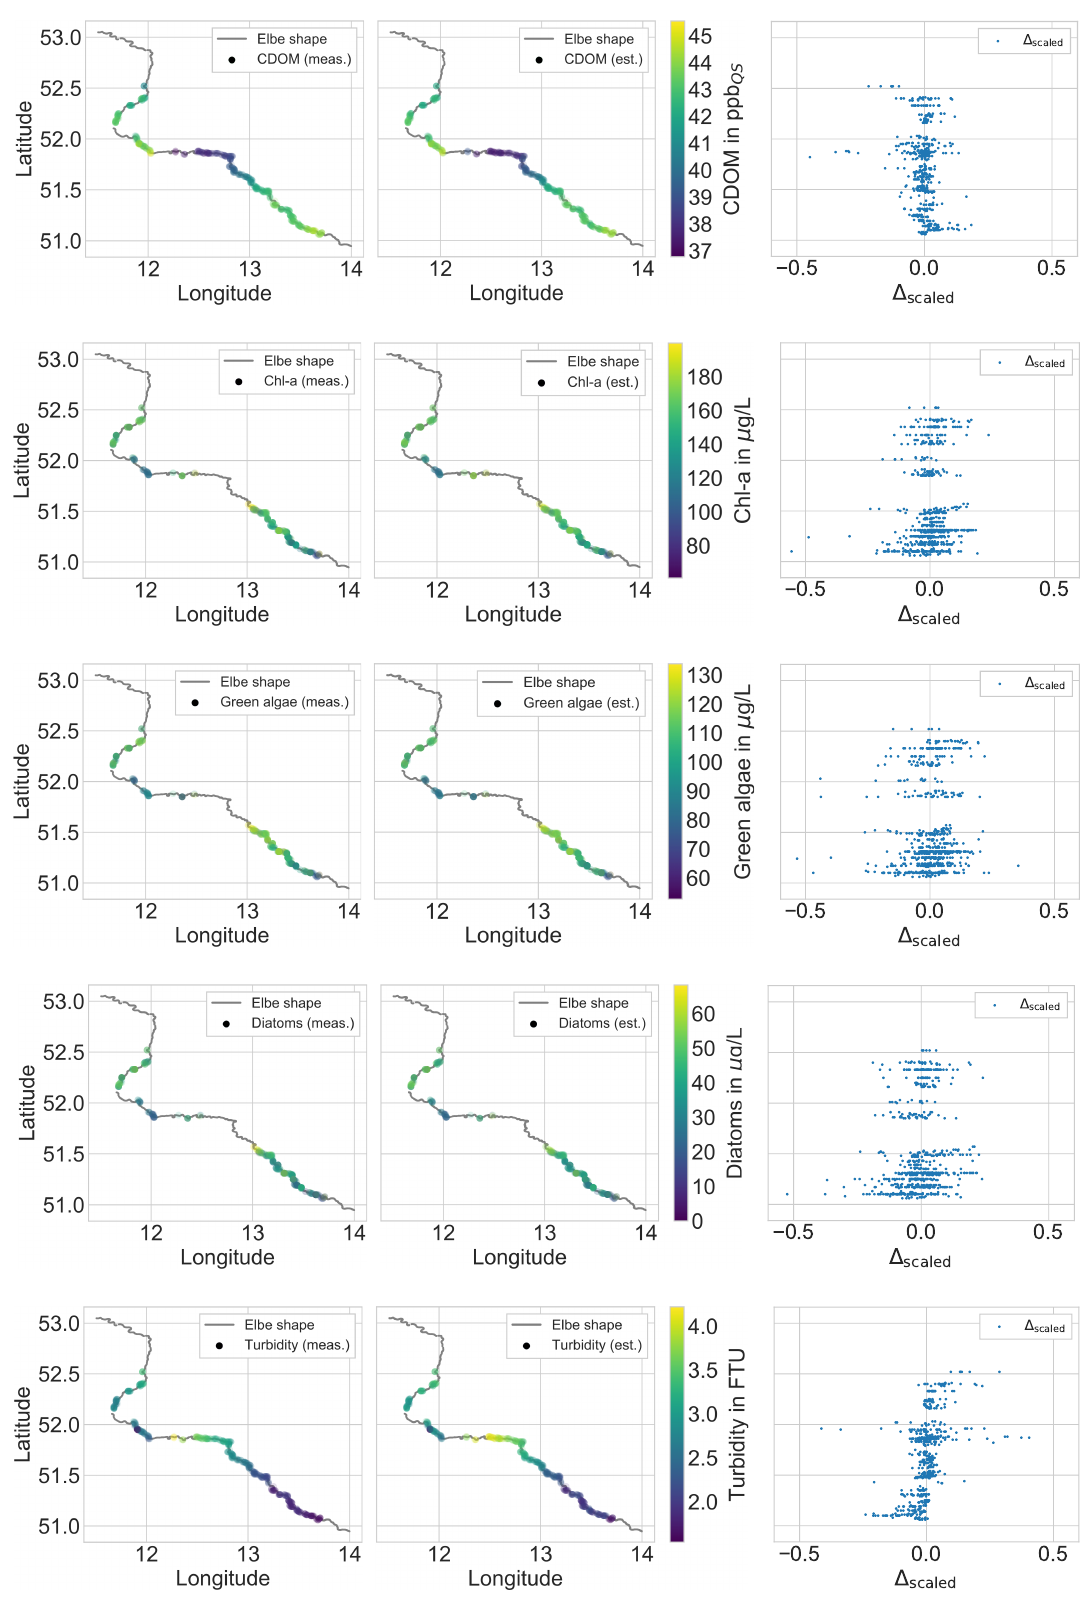
Figure 5. Visualization of the regression results generated by the ET model (central columns) compared to the real probe measurements (left columns) matched with their respective recorded GPS data along the river Elbe. The min-max scaled deviations ∆ scaled between the measured (meas.) and the estimated (est.) values of the water quality parameters are illustrated in the right columns. We refer to the chlorophyll a concentration in this plot as